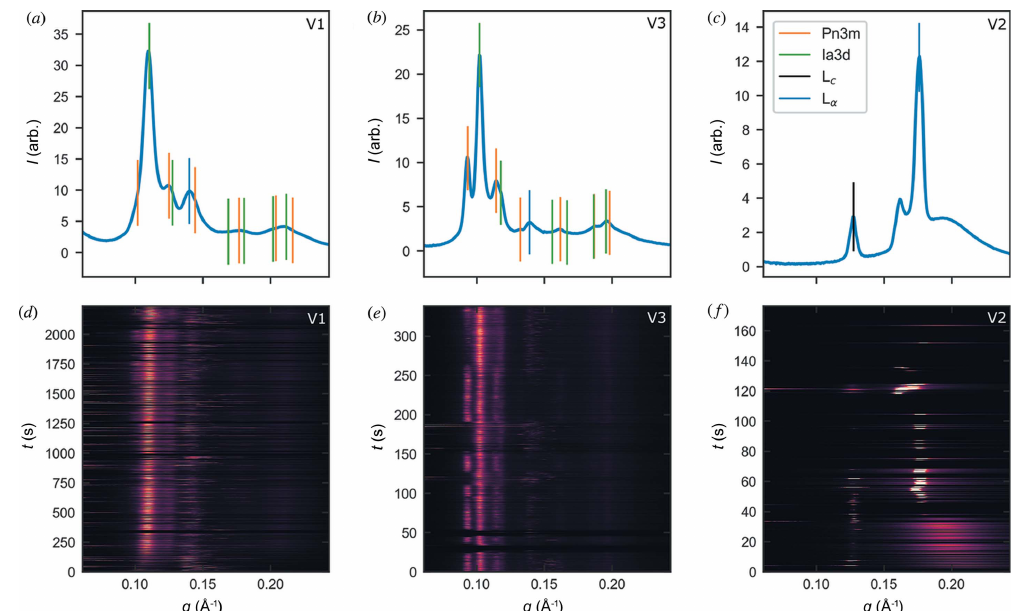
Figure 4 Radial diffraction profiles captured during injection into vacuum at the LCLS. The two samples prepared with a 60:40 MO/water ratio, ( a , d ) V1 and ( b , e ) V3, exhibit the Ia 3 d and Pn 3 m phases occurring simultaneously. The positions of peaks associated with these phases are shown as vertical lines in plots ( a )–( c ). An L (cid:2) peak is also observed in these samples with a structure parameter of around 45 A˚ . The 85:15 MO/water sample, ( c , f ) V2, was the only sample observed with an L c phase during vacuum injection. The L (cid:2) phase with the structure parameter 37.5 A˚ is also observed in this data, which is consistent with the previous studies for this